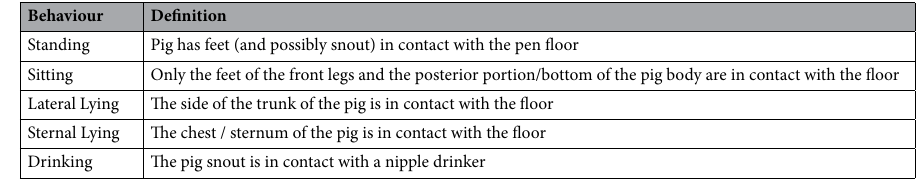
Table 3. Definitions of the behaviours recorded in the